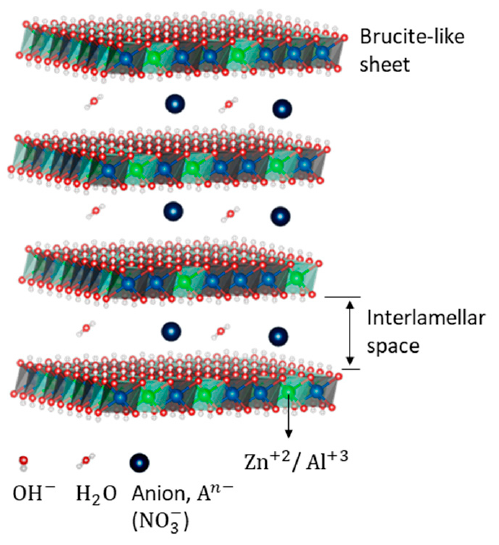
Figure 1. Schematic representation of the layered double hydroxide (LDH) structure, showing the staking of the positively charged (cid:4670)Zn negatively charged (cid:3427)A